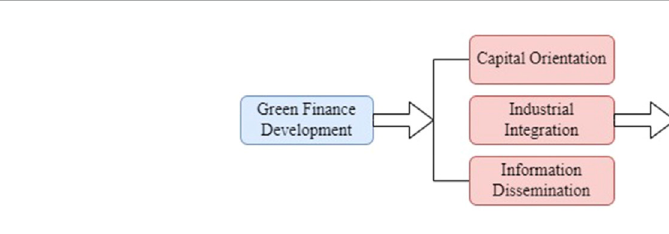
FIGURE 1 The transmission mechanism of green fi nance development impact energy